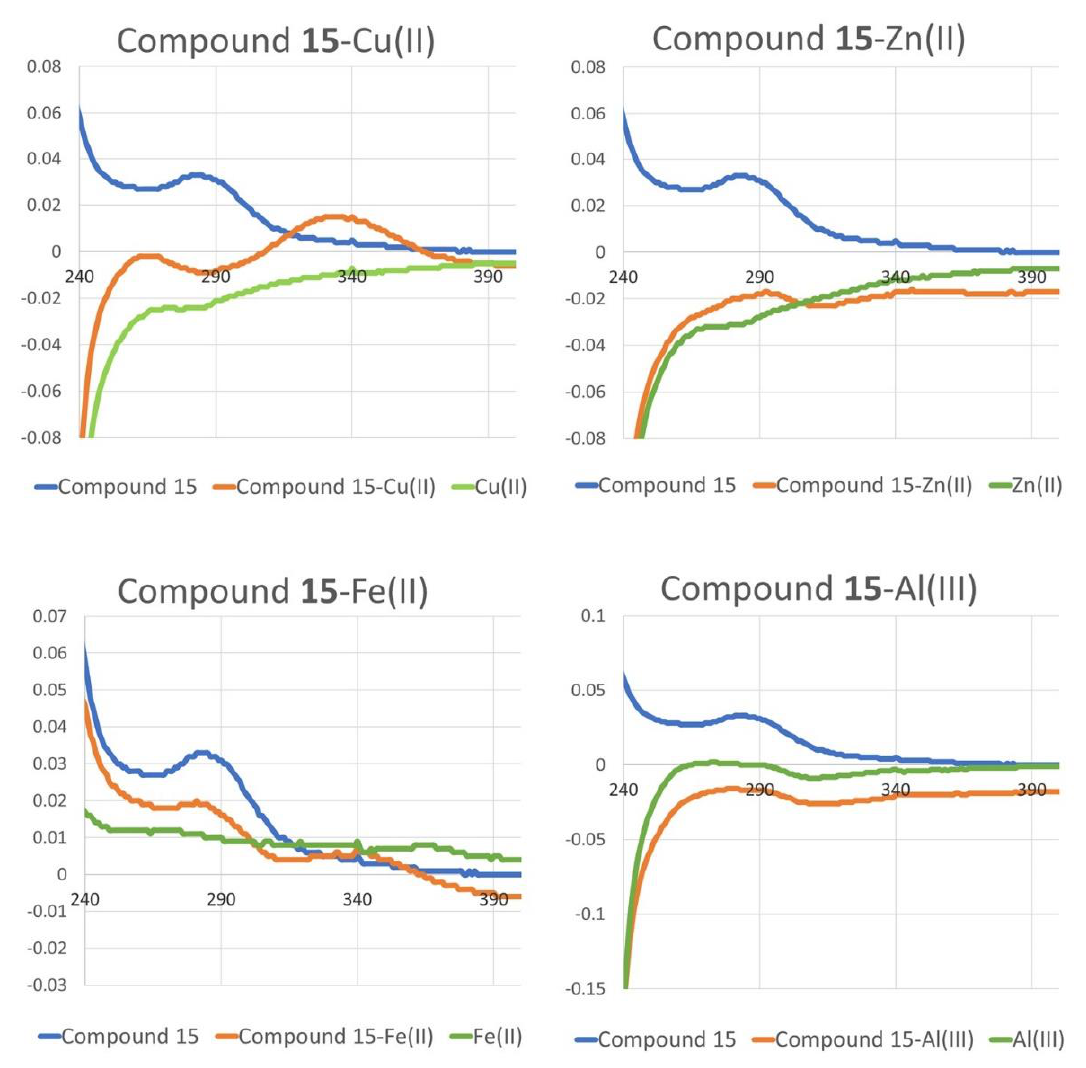
relevant ions. Compound 15 was found to be a selective copper chelator, as it is shown in Figure 9. In the complex 15 -Cu 2+ spectrum, there is a perceptible wavelength shift from λ = 284 to λ = 334 nm, indicating a conformational rearrangement due to the interaction with Cu(II). Through the analysis of the remaining spectra, it is possible to verify that there is no relevant interaction of this nucleoside with the other ions. Compound 16 was shown to be a non-selective chelator, as the resulting spectra showed conformational rearrangements induced by interaction with all the tested ions, as can be verified in Figure 10. Interactions with copper, zinc, iron and aluminum ions result in wavelength shifts from λ = 290 nm to λ = 345, 346, 339, and 351 nm, respectively.